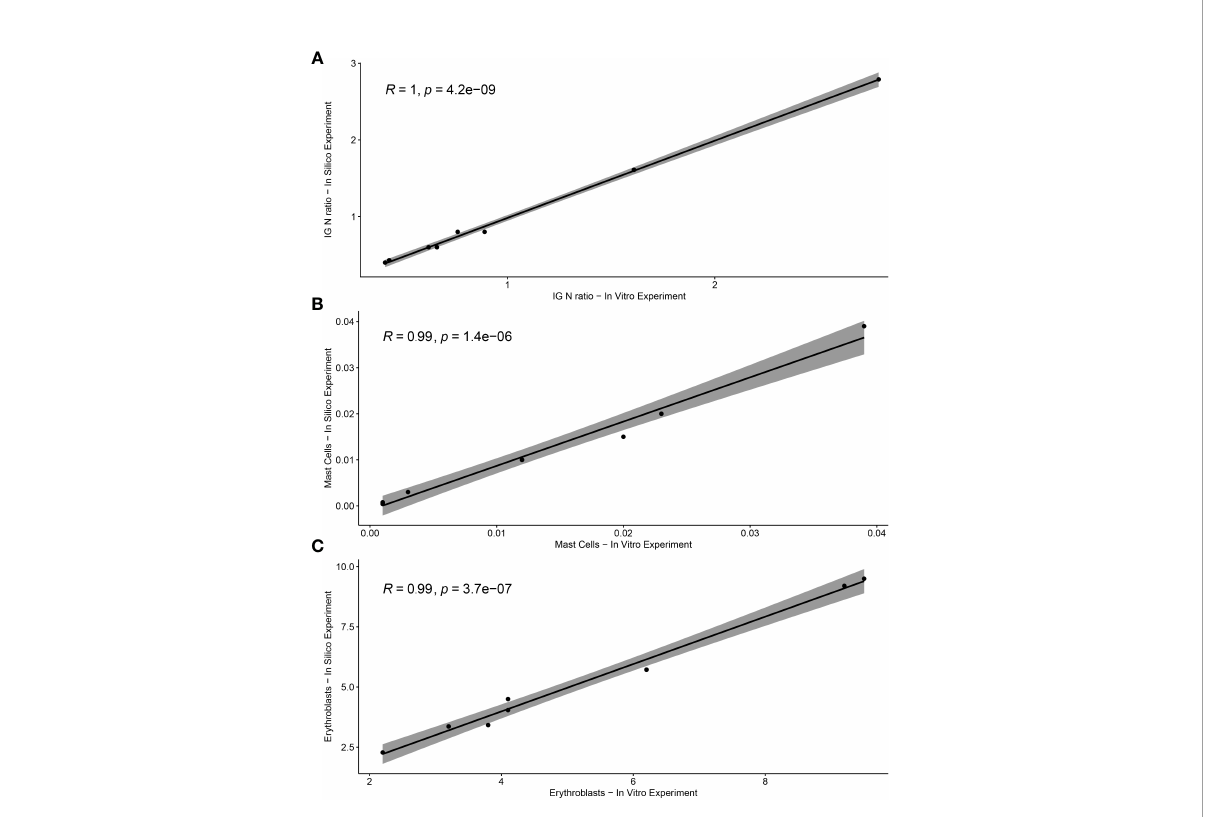
FIGURE 7 Correlation between in vitro and in silico -calculated data of ALLgorithMM parameters. The Pearson ’ s rho (R) accompanied by the relative p-value for (A) IG/N ratio, (B) mast cells, and (C)